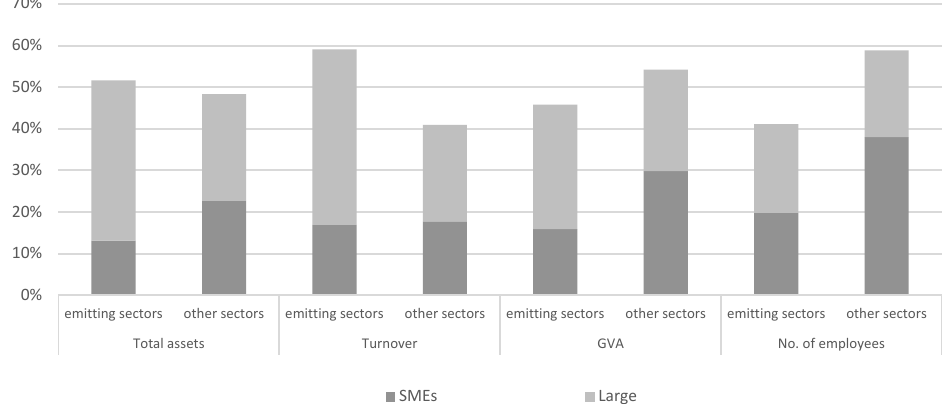
Figure 4. Basic statistics: emitting sectors versus other sectors. 0%2%4%6% emitting sectors